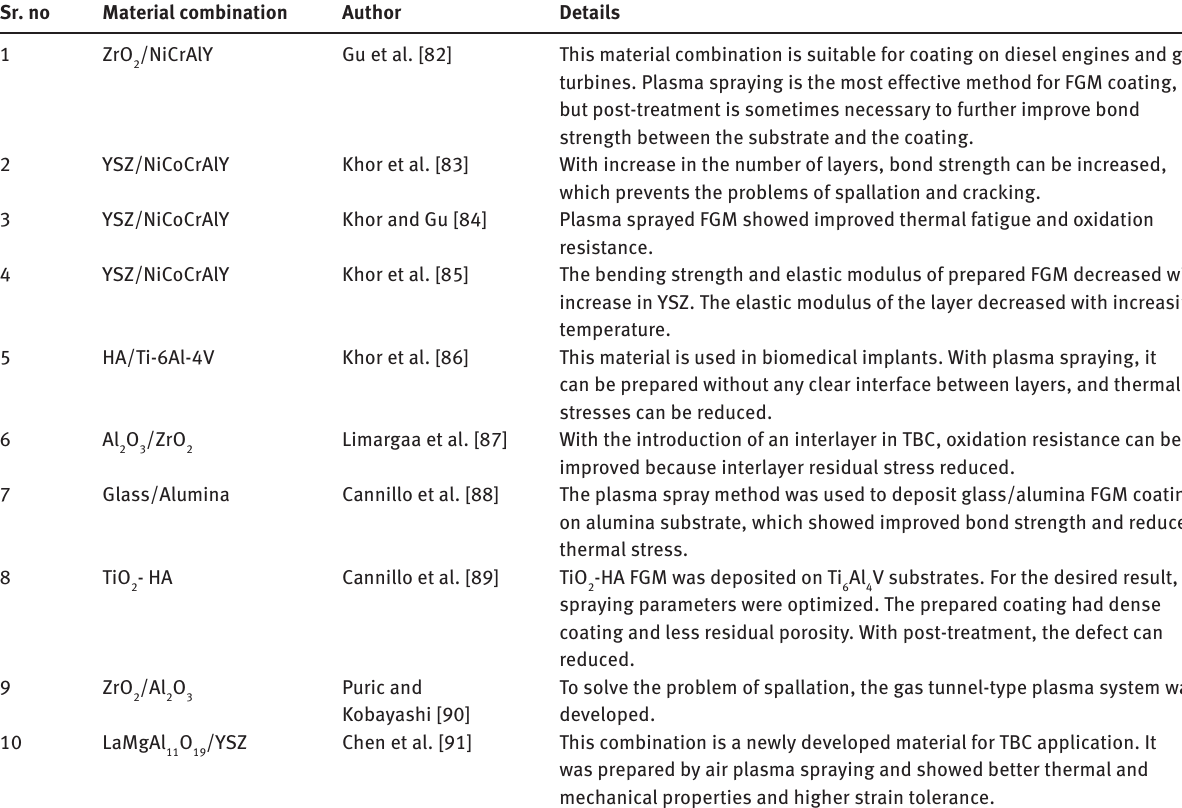
Table 7: List of different authors who used plasma spraying for fabrication of FGM. Sr. no Material combination